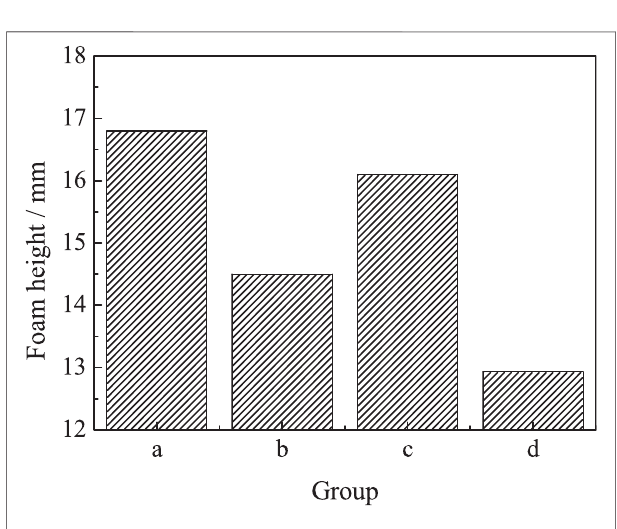
FIGURE11| Foamheightwithdifferentparticlecombinationafter2